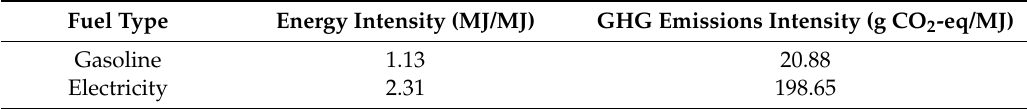
Table 6. The energy and emission intensities of gasoline and electricity production in